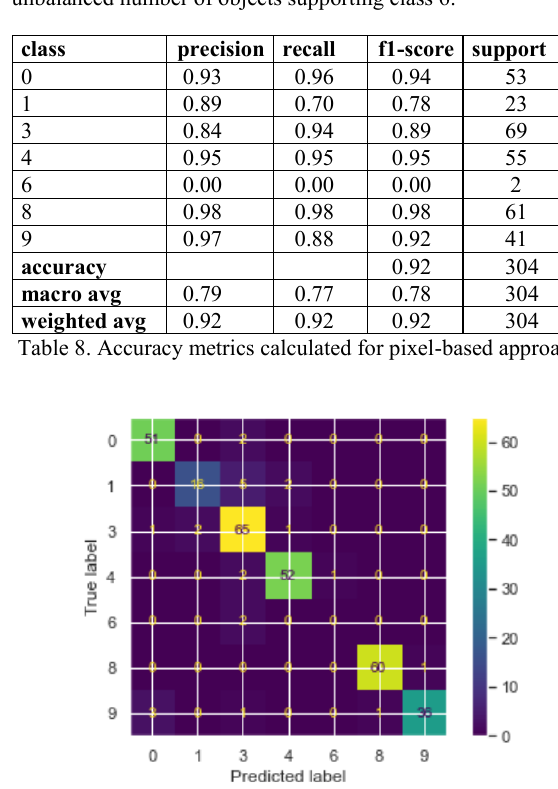
Figure 7. Normalized confusion matrix for pixel-based RF